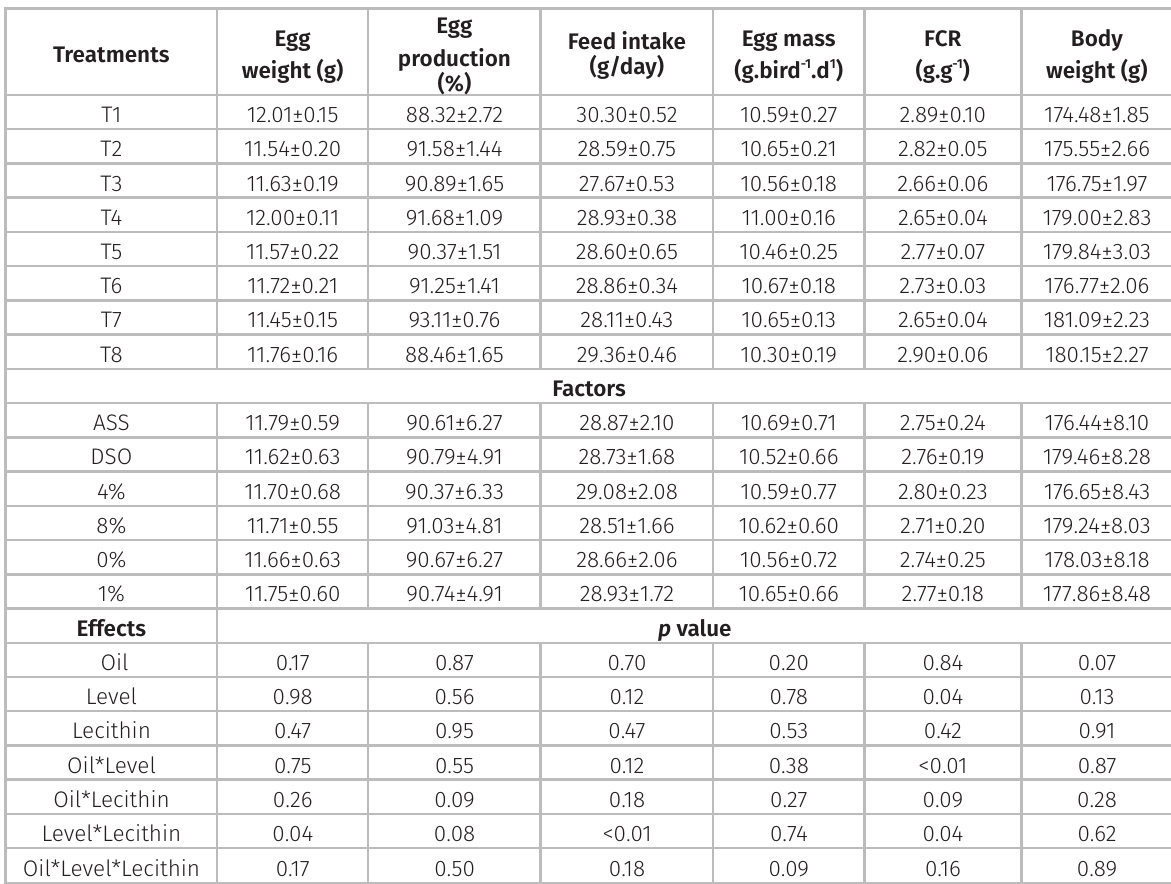
Table II. Influence of acidulated soybean oil (ASS) and lecithin fed to Japanese quails during six productive periods on productive performance (mean ± standard